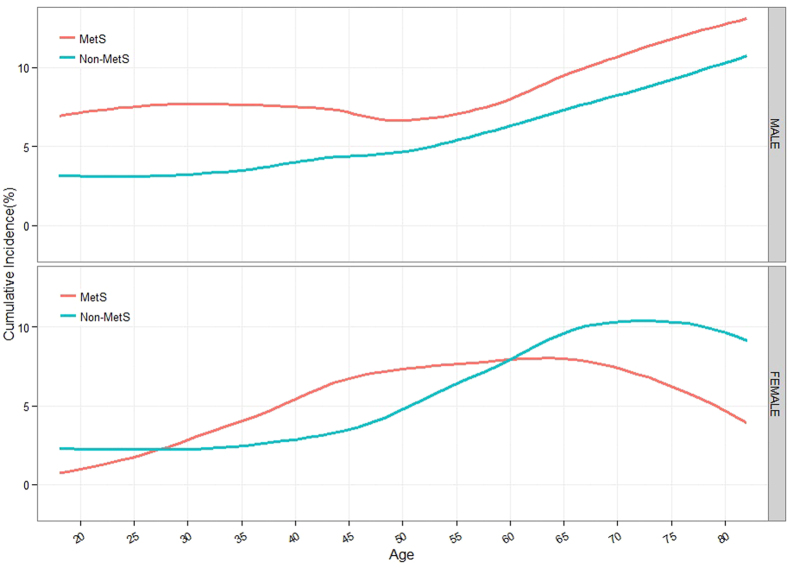
Modeled cumulative incidence of gallstone disease from age 18 to 82, stratified by sex and MetS status.The curves were modeled by real cumulative incidence of gallstone disease. Curves of cumulative incidence of gallstone disease among persons with MetS are in red; curves of cumulative incidence of gallstone disease among persons without MetS are in blue.